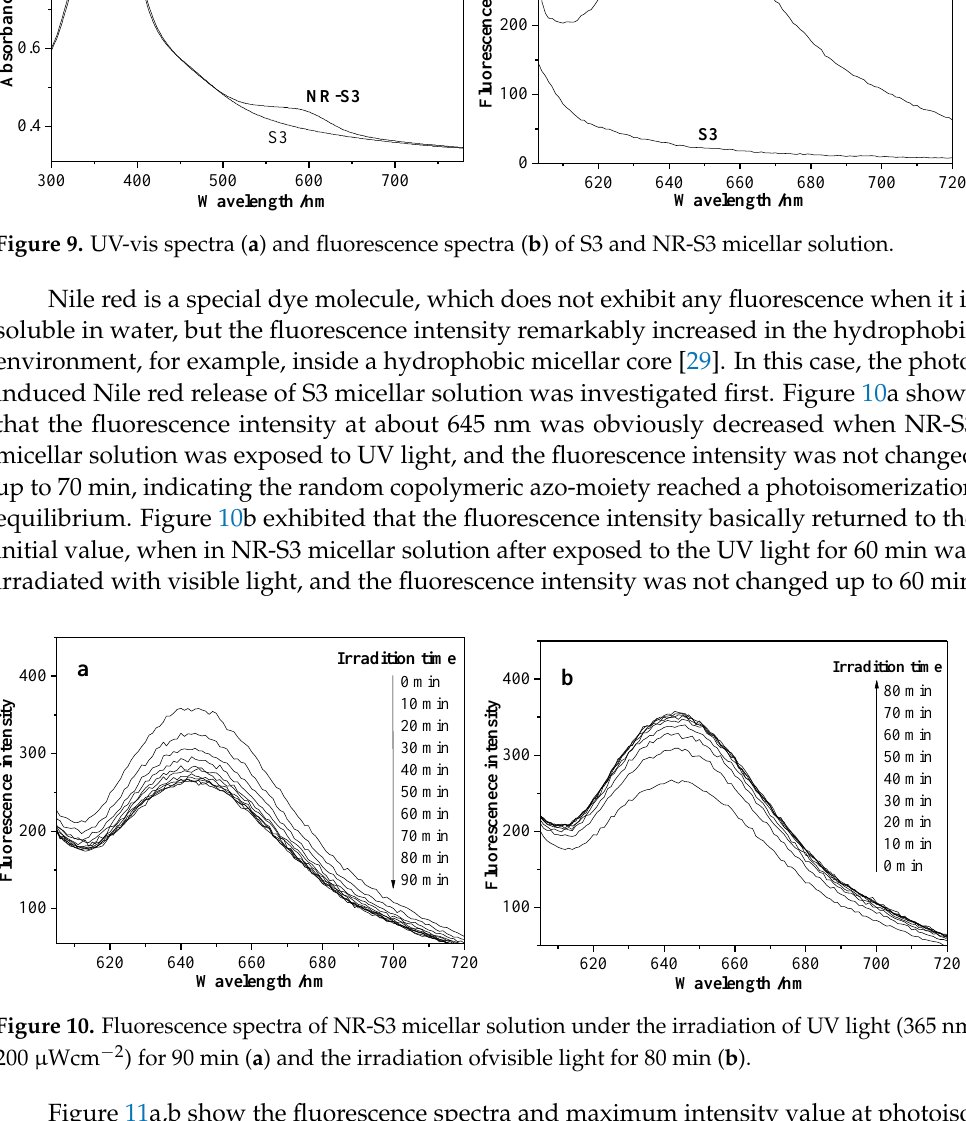
Figure 11. Fluorescence spectra of NR-S3 micellar solution under alternating UV and visible light irradiation to the photostationary state four times ( a ) and evolution of their maximum fluorescence intensity ( b ). It is well known that the hydrophobic azobenzene polymer (PAZO) segments would become a little hydrophilic under the UV-light irradiation due to the photoisom- erization of the azobenzene moieties [30]and the fluorescence intensity of Nile red be- comes weaker in a less hydrophobic environment [31]. Therefore, the decrease in the fluorescence intensity of micellar solution was attributed to the more hydrophilic envi- ronment due to the PAZO photoisomerization under UV light irradiation. From Figure 10b, the fluorescence spectra returned to the initial value under the visible light irradia- tion, which indicated that there was no leakage of Nile red at the process of PAZO pho- toisomerization. On the other hand, from Figure 11, the fluorescence spectra and maxi- mum fluorescence intensity value between cis - trans and trans - cis processes at the pho- toisomerization equilibrium point was not changed under alternating UV and visible light irradiation several times, indicating the micellar solution changed only in its inter- nal hydrophobic/hydrophilic environment without any disruption of micellar structure under the irradiation of UV light. The photo-responsive micelles have a potential appli- cation in sensors or catalysts, which need the release of encapsulated substances to pre- vent pollution of the environment or could influence the chemical reaction system. In order to investigate the influence of external temperature on micellar release properties, the fluorescence spectra of NR-S3micellar solution was recorded at the heat-